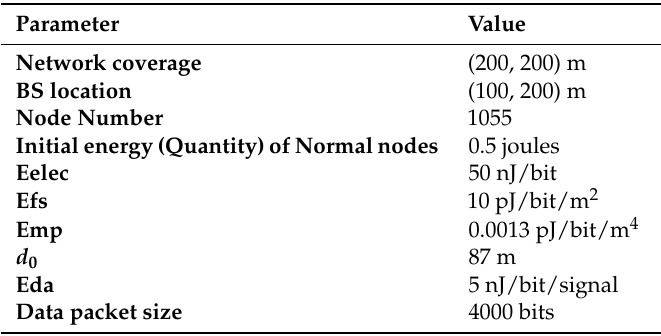
Table 1. Parameters used in